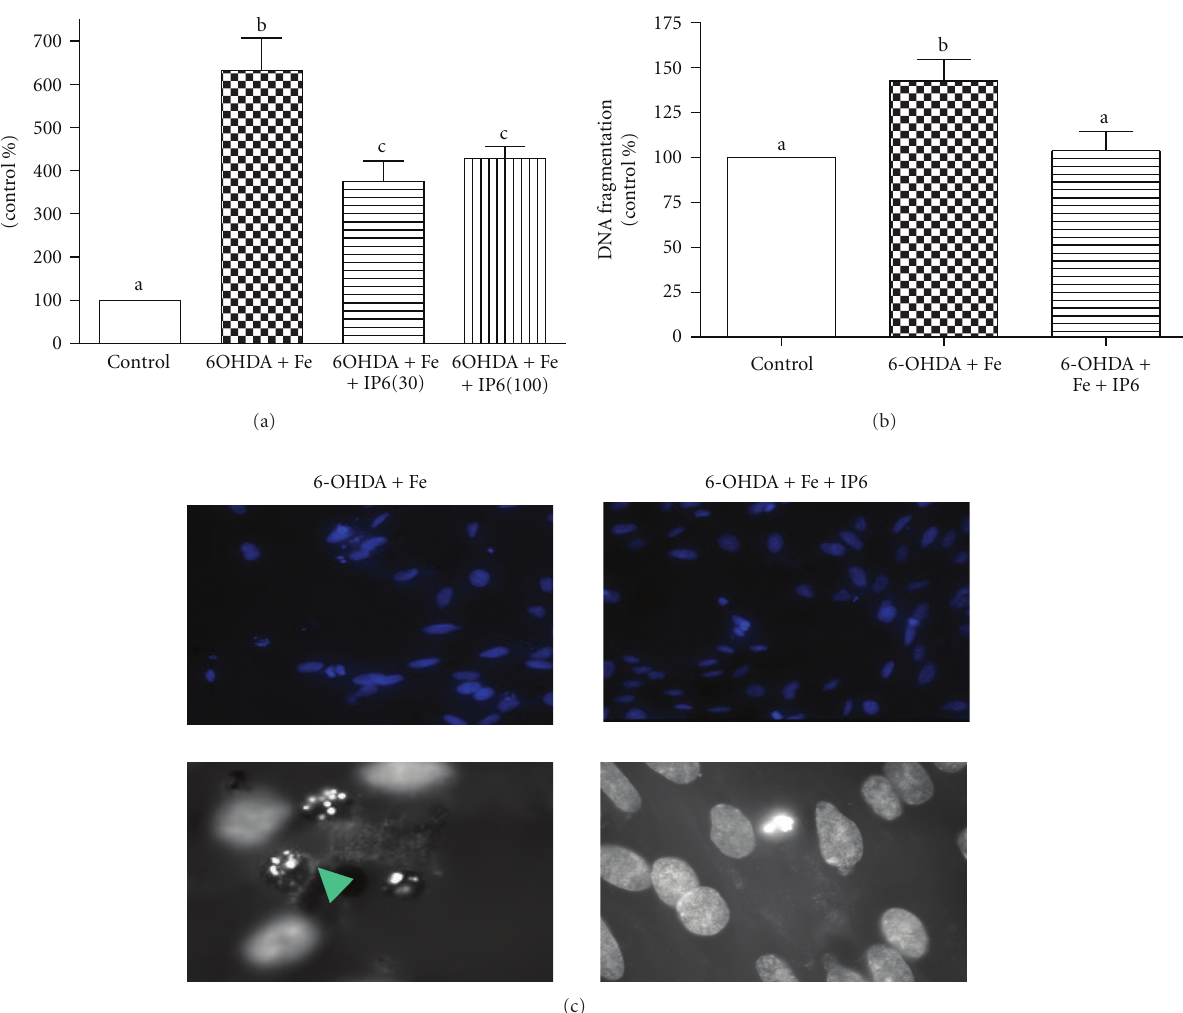
Figure 2: Protection of IP6 against 6-OHDA-induced apoptosis in the iron-excess condition in vitro cell culture model. Cell apoptosis was measured as caspase-3 activity (FU/mg protein, (a) n = 4-5 from one experiment) with 30 and 100 μ mol/L IP6. DNA fragmentation (AU/mg protein, (b) n = 3-4 from one experiment) and Hoechst nuclear staining (c) were tested with only 30 μ mol/L of IP6. ANOVA with Tukey’s Multiple Comparison test was used to detect the di ff erences among the treatments in (a) and (b), and means with di ff erent letters were significantly di ff erent ( P < . 05). The top panel in C represents 20x magnification and the bottom panel represents 60x magnification. Apoptotic nucleus is indicated with an